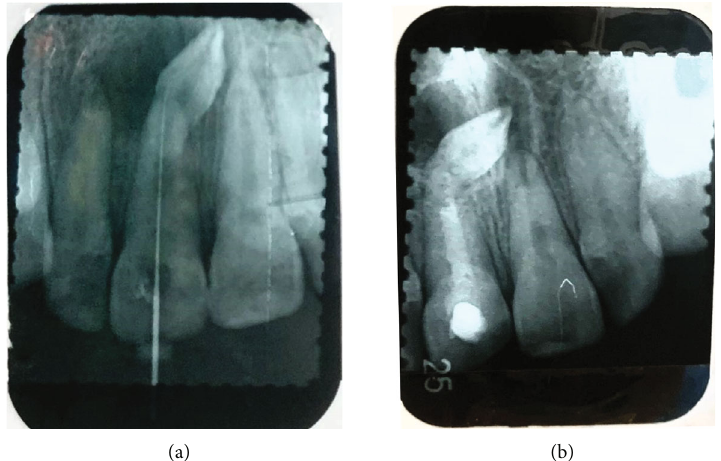
Figure 1: Periapical radiograph: (a) #11 with open apex; (b) one year later found apexi fi cation material on root canal and closed apex. The impacted mesiodens shown surrounded with cyst between apical of #21 and